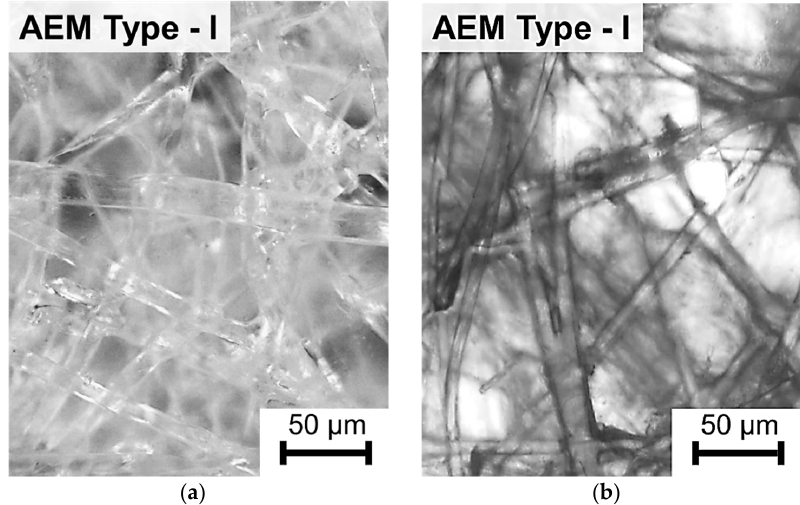
Figure 4. Optical images of the swollen AEM Type-I membrane. Before the study, samples were soaked in 0.02 М NaCl solution for 24 h ( a ) and in the 0.02 М NaCl solution where the high molecular weight dye (anthocyanin) was added ( b ).